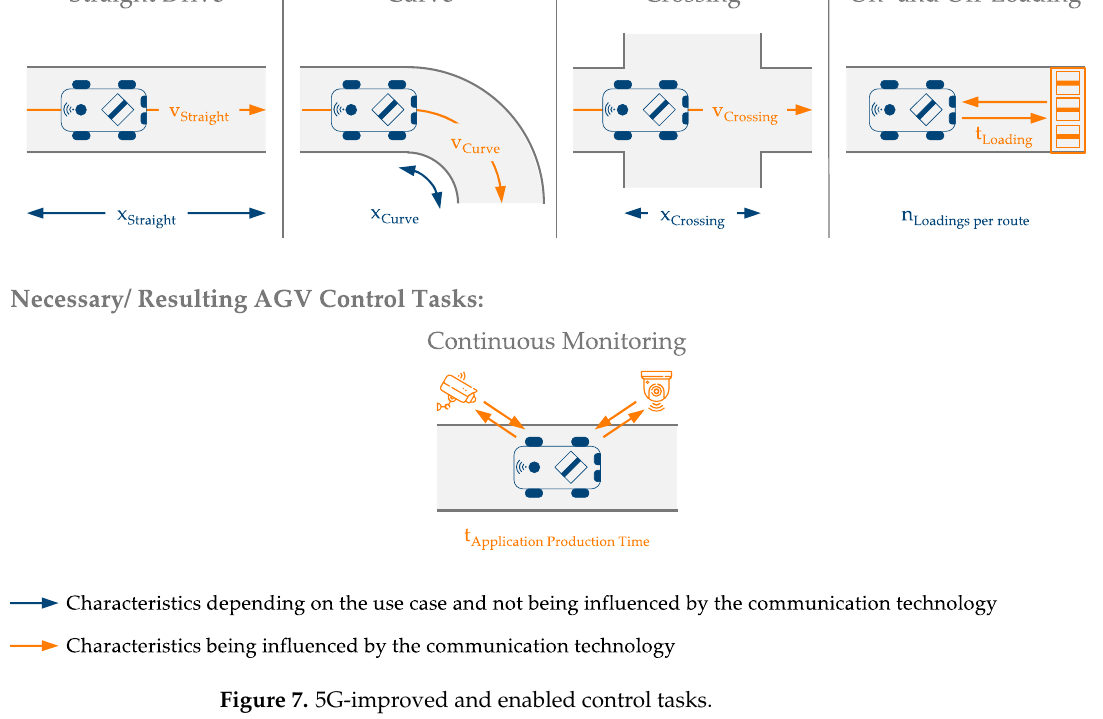
Table 2. Technical goals when implementing 5G technology in production.